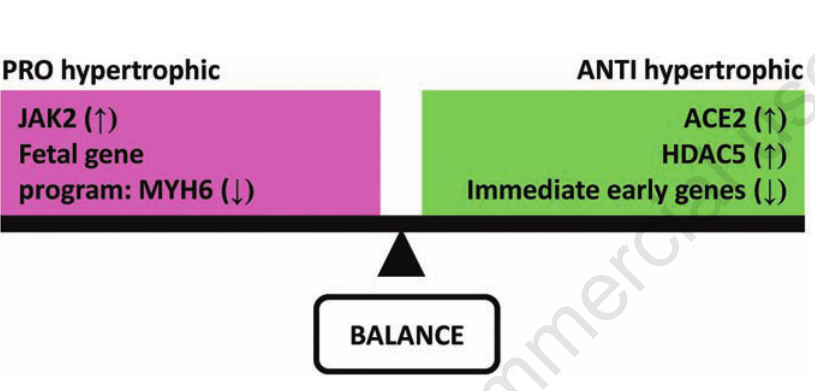
Figure 3. The balance of pro (pink box) and anti (green box) hypertrophic genes, path- ways and mechanisms. Pro hypertrophic mechanisms are highlighted by the transcrip- tional down-regulation of MYH6 , indicating that the switch to the fetal gene program is maintained, and the transcriptional up-regulation of JAK2 in the JAK-STAT pathway. The anti hypertrophic mechanisms were seen as a transcriptional down-regulation of the IEGs, FOS and EGR1 , and a transcriptional up-regulation of ACE2 and HDAC5 . ↑ and ↓ indicates change in gene expression in patients compared to